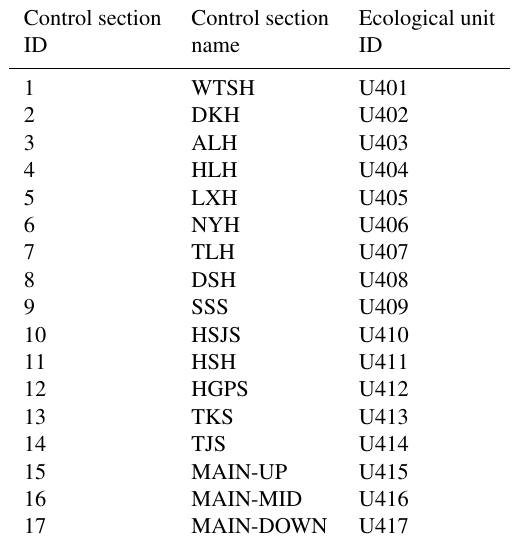
Table 3. Scheme for E-WAS calculation.